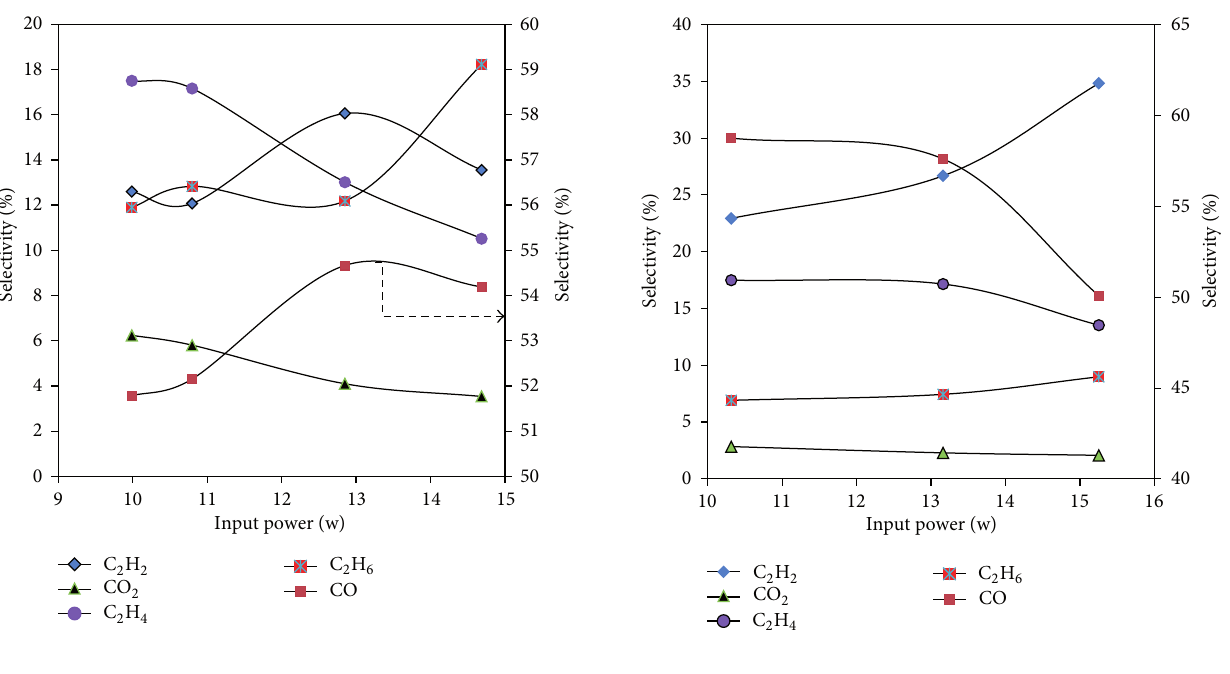
F 5: Selectivity of products versus input power supplied to the reactor over combined ZSM5 and corona discharge